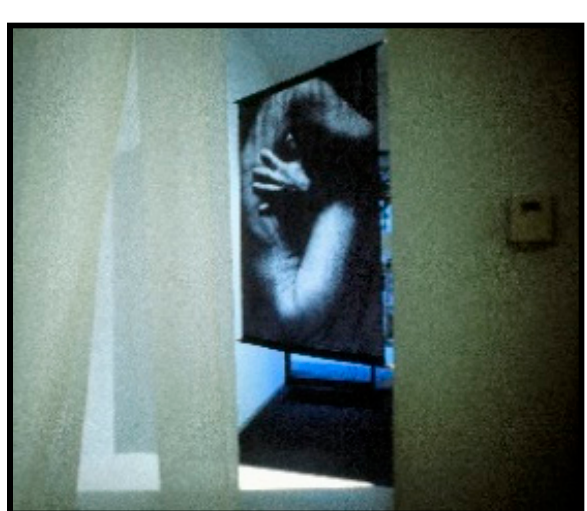
Figure 9. The defined space.